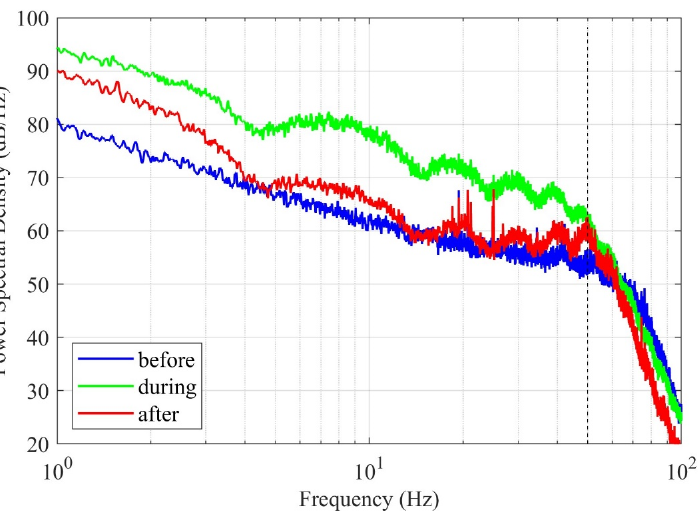
Figure 15. The averaged power spectral density from OSU1-W from 18 May 2019 for the period before (30–60 min before the EF0 tornado), during (from touchdown at 14:27 UTC until the storm passed OSU1), and after (30–60 min after the storm passed OSU1) the QLCS tornado. Vertical dashed line marks the cutoff frequency.